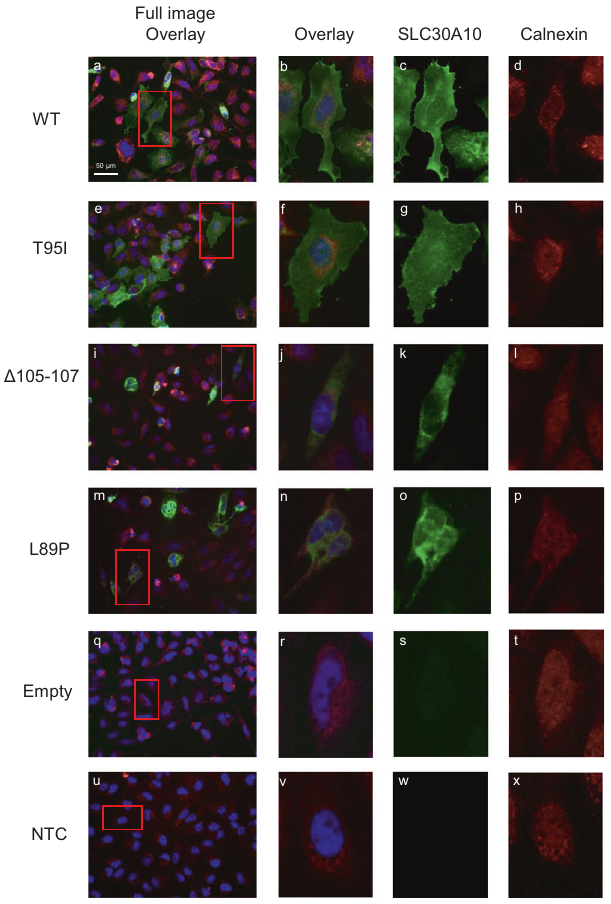
Fig. 6 Immuno fl uorescence imaging of SLC30A10 protein constructs expressed in cultured HeLa cells. WT = wild type ( a – d ); T95I = Thr95Ile ( e – h ); Δ 105 – 107 ( i – l ) and L89P ( m – p ), HMNDYT1-causing variants reported previously 56 ; empty = transfected with empty vector ( q – t ); NTC = non transfected control ( u – x ). Calnexin staining (in red) indicates the endoplasmic reticulum (ER). Color balance has been adjusted globally to improve the contrast between channels in overlay images; original unadjusted micrographs are provided as a Source data fi